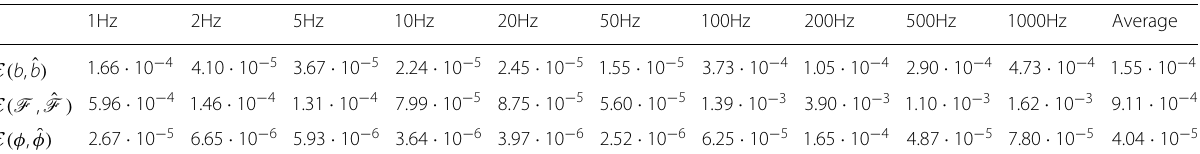
Table 1 Leave-one-out cross-validation results